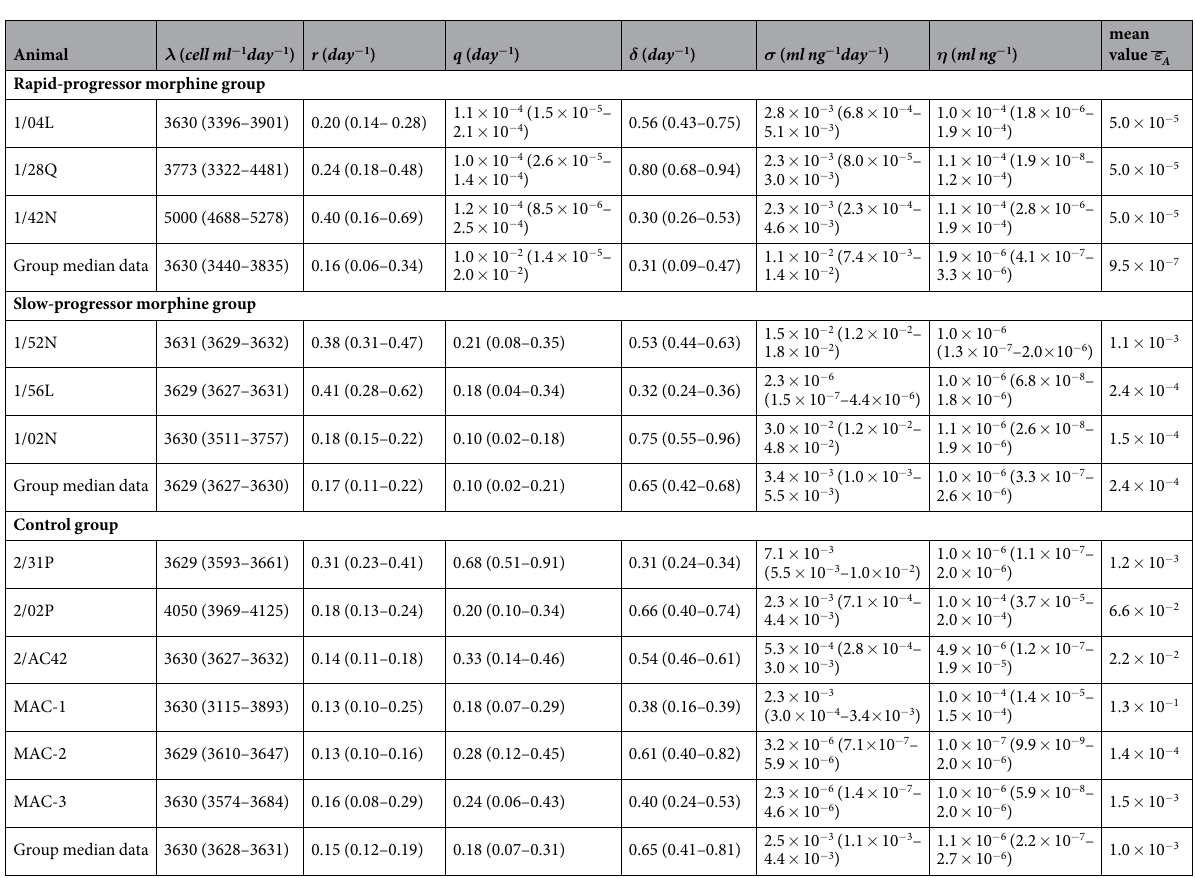
Table 3. Model-2 (the best model) estimated parameters for individual animals, fitted parameter values to the group median data (the median data of each group), and their 95% confidence intervals in parentheses, and the mean values of ε A calculated over a period of 200 days post infection using ∫ ε = η rapid-progressor morphine group, we can obtain the analytic solution for ε = η